Question: What does this figure show? Answer in one sentence.
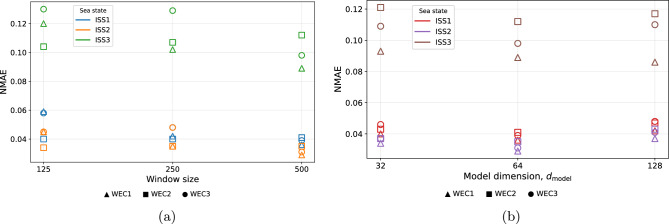
Answer: ( a ) Sensitivity analysis of the input window size. The NMAE (equation ( 14 )) obtained for the three sea states (ISS1–ISS3), and the three WECs is shown for window sizes of 125, 250, and 500 time steps, while all remaining model hyperparameters are kept fixed at their baseline values. ( b ) Sensitivity analysis of the transformer latent dimension, \documentclass[12pt]{minimal} \usepackage{amsmath} \usepackage{wasysym} \usepackage{amsfonts} \usepackage{amssymb} \usepackage{amsbsy} \usepackage{mathrsfs} \usepackage{upgreek} \setlength{\oddsidemargin}{-69pt} \begin{document}$$d_{\textrm{model}}$$\end{document} . The NMAE (equation ( 14 )) obtained for the three sea states (ISS1–ISS3) and the three WECs is shown for \documentclass[12pt]{minimal} \usepackage{amsmath} \usepackage{wasysym} \usepackage{amsfonts} \usepackage{amssymb} \usepackage{amsbsy} \usepackage{mathrsfs} \usepackage{upgreek} \setlength{\oddsidemargin}{-69pt} \begin{document}$$d_{\textrm{model}}=$$\end{document} 32, 64, and 128 units, while all other hyperparameters are maintained at their baseline values.